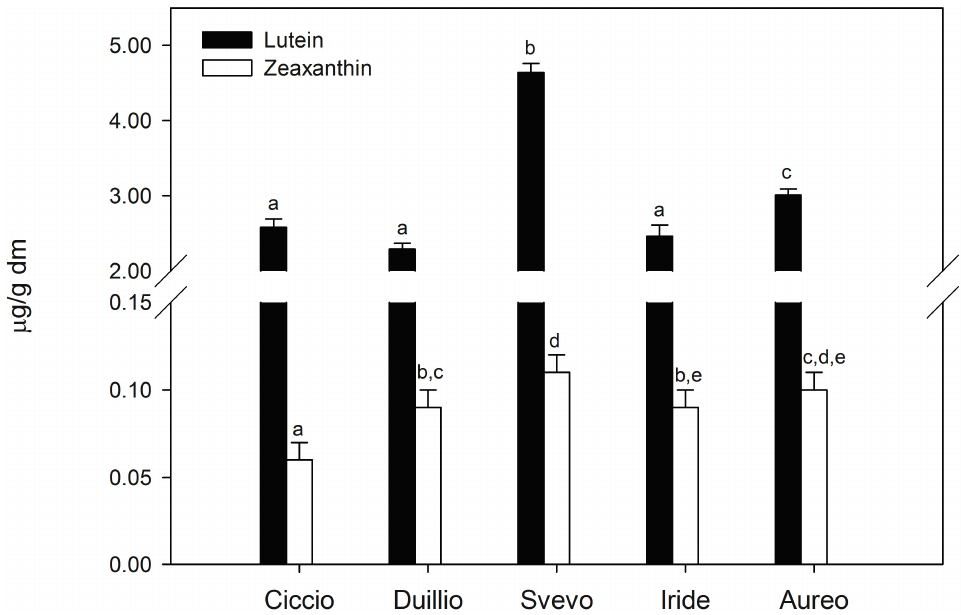
Figure 2. Content of carotenoids, expressed as μ g/g dm, in the whole meal flour of five, Italian, durum wheat cultivars. Different letters, within each histogram series, indicate significant differences between different samples ( n = 3, p <